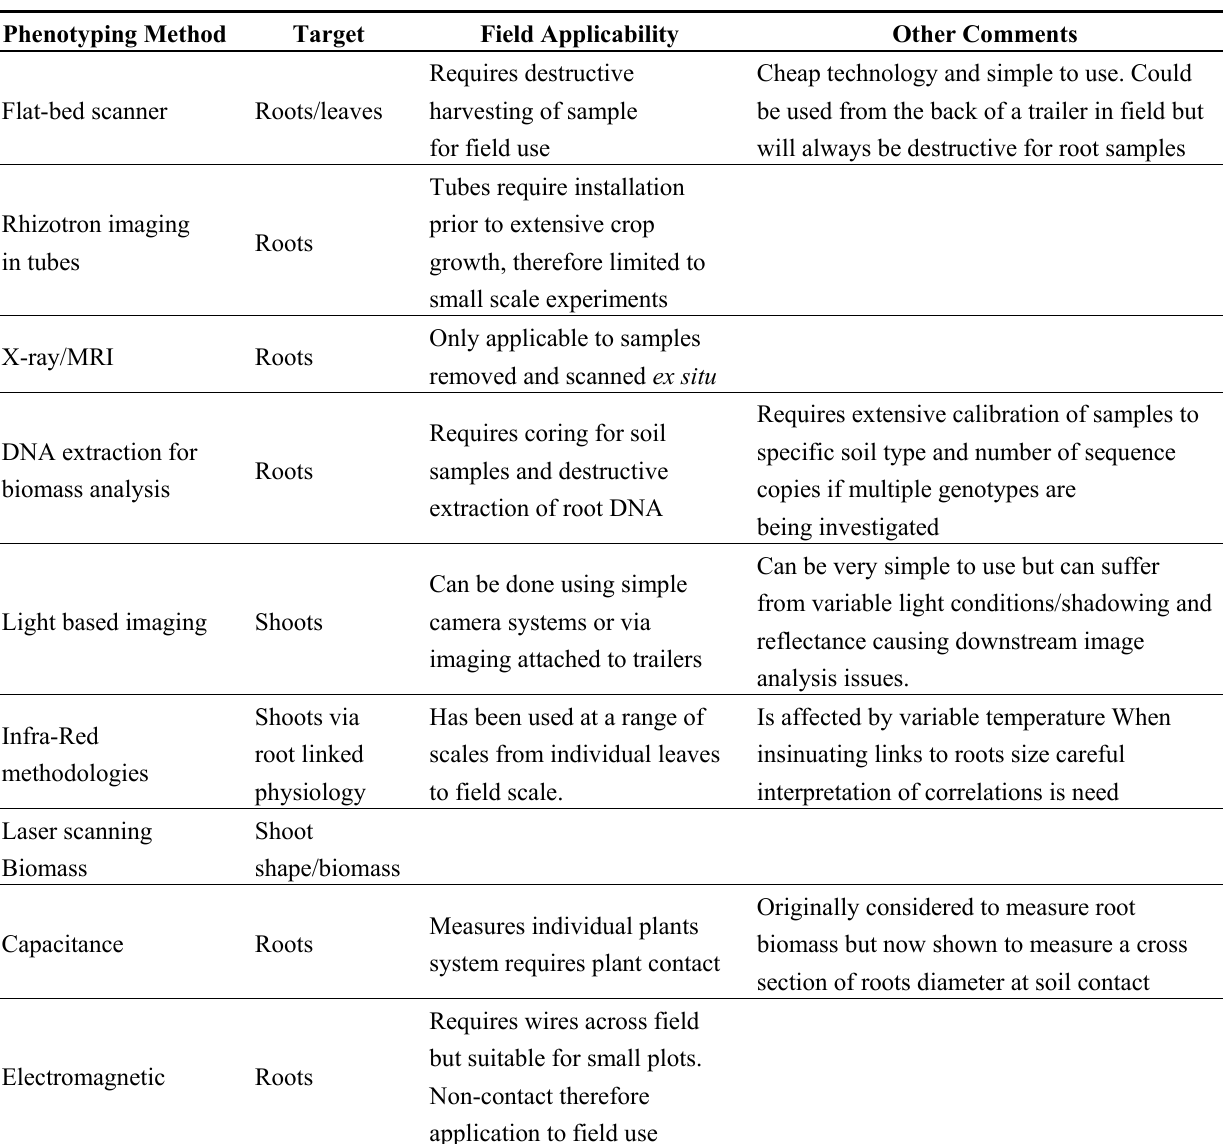
Table 1. Phenotyping techniques and their applicability to the